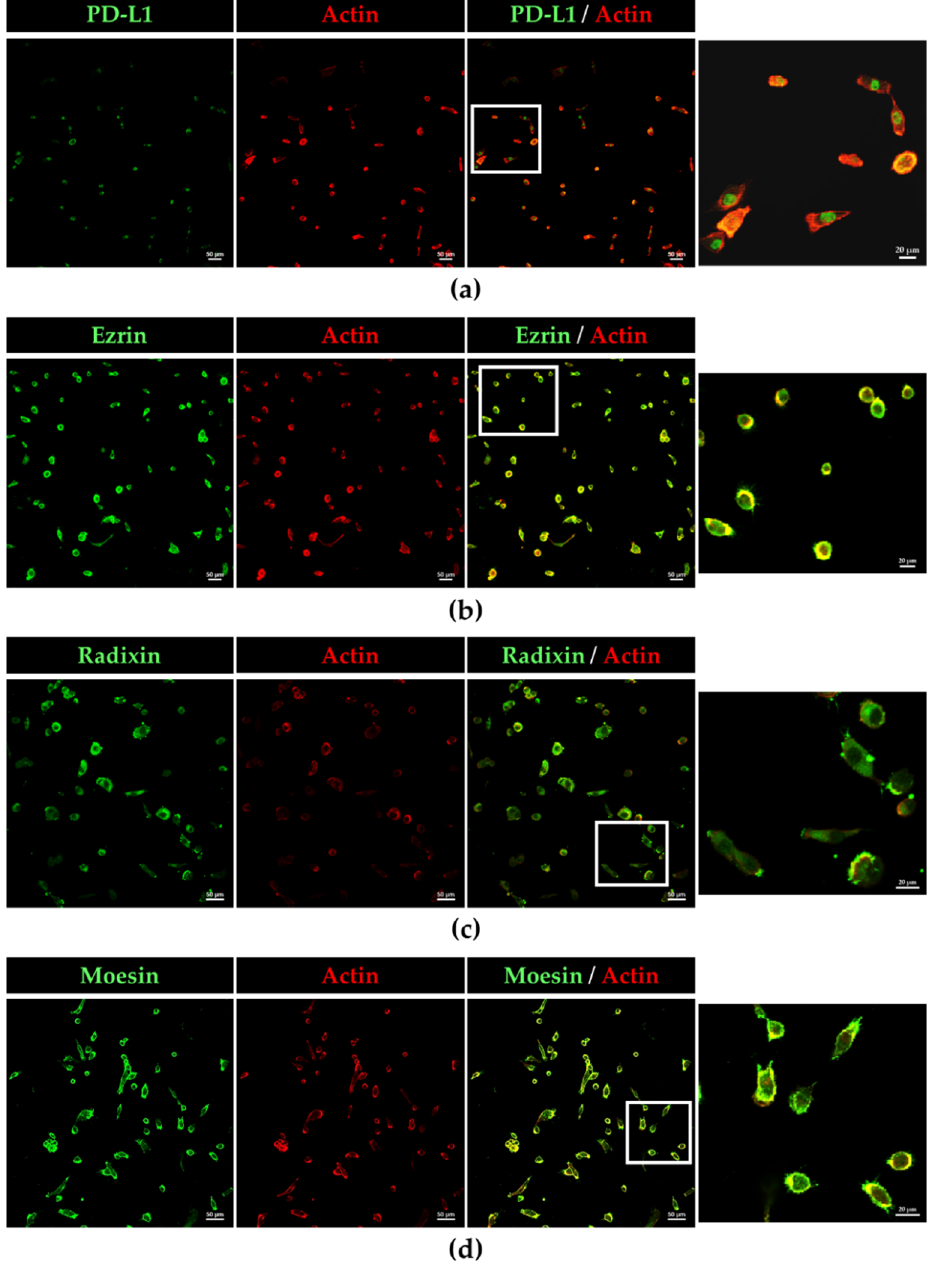
Figure 2. Confocal laser scanning microscopy (CLSM) analysis of the subcellular distribution of PD- L1, ezrin, radixin, and moesin in BOKU cells. ( a ) PD-L 1, ( b ) ezrin, ( c ) radixin, and ( d ) moesin labeled with Alexa Fluor 488 (green) highly colocalized with F-actin labeled with tetramethylrhodamine (red). Scale bars: 50 µ m. Higher magnification images in the rightmost are from the corresponding white rectangle region in the merged panels. Scale bars: 20 µ m. All images are representative of at least three independent